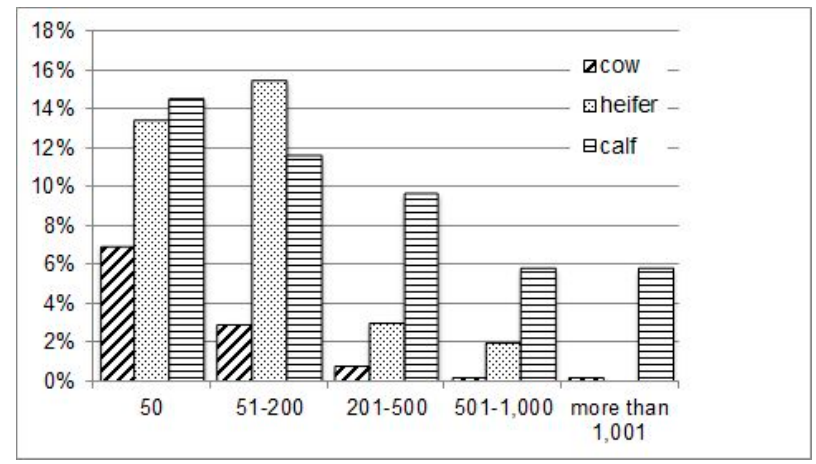
Figure 2. Distribution of samples with an oocyst count per gramme faeces (OCG) from 50 to more than 1001 oocysts in samples positive for Eimeria spp. (in % of all samples, n = 143) with regard to the age classes (cow, heifer, calf) in suckler cows.